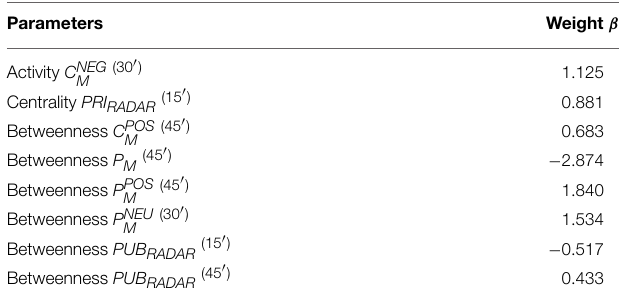
TABLE 6 | Function parameters discriminating the subjects who change their final